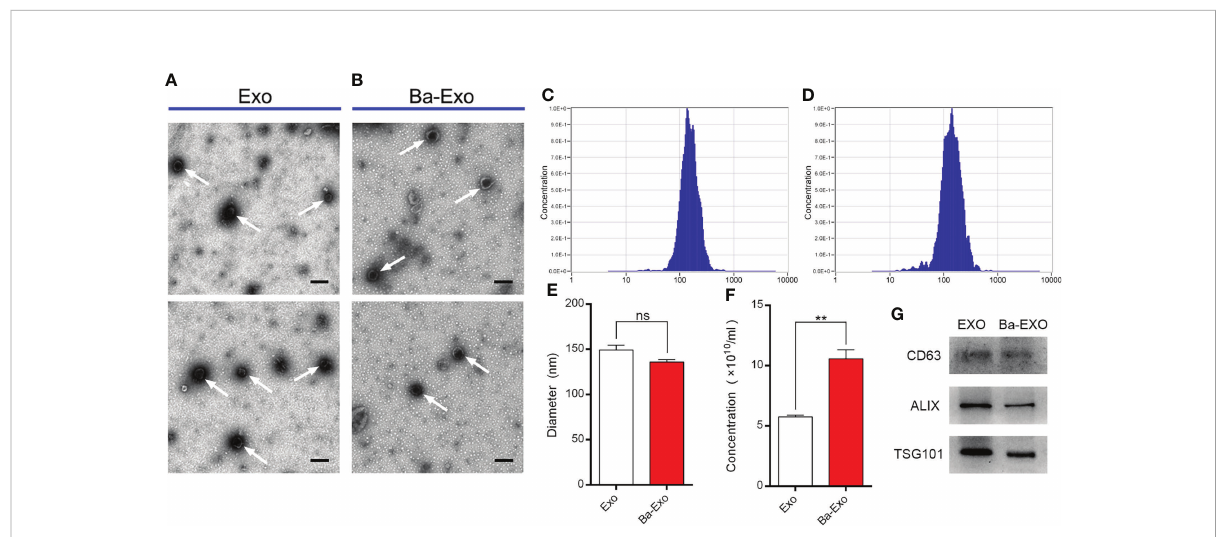
FIGURE 1 Characterization of exosomes (Ba-Exo and Exo) from IPEC-J2 with or without Ba-treatment. (A, B) , Representative images of Ba-Exo and Exo by transmission electron microscopy. Arrowheads indicate the cup-shaped vesicles. Scale bar: 200 nm. (C, D) , The size distribution of exosomes Exo and Ba-Exo by nanoparticle tracking analysis. (E) , Statistical analysis of the diameters between exosomes Exo and Ba-Exo. (F) , Statistical analysis of the concentration between exosomes Exo and Ba-Exo. (G) , Western blot analysis of the typical exosomes-associated proteins. Mean ± SD of three independent experiments are shown. **p < 0.01, ns, not signi fi cant. IPEC-J2, intestinal porcine epithelial cell lines; SD, standard